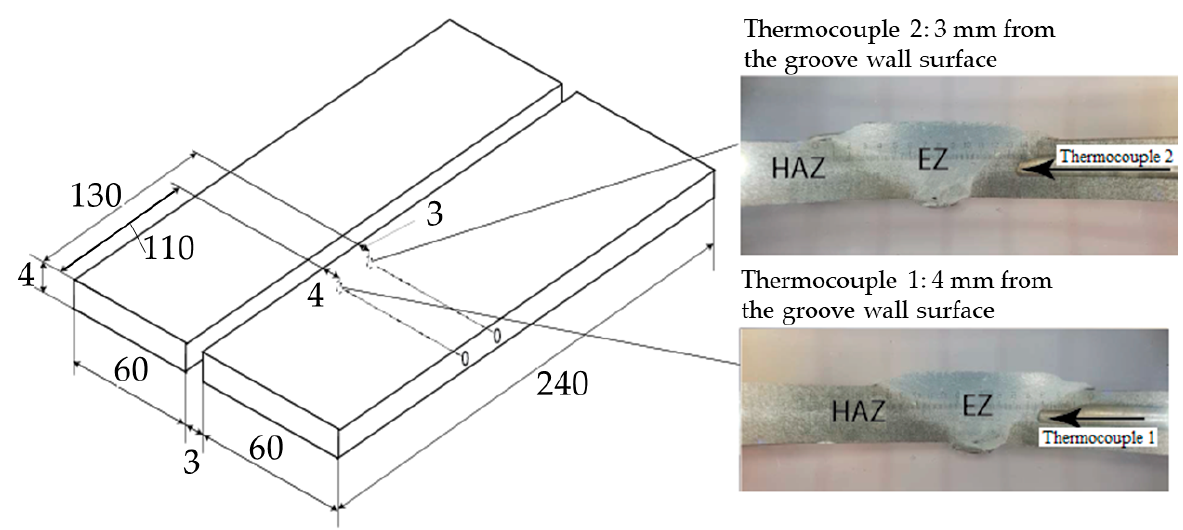
Figure 6. Workpiece dimensions and locations of thermocouples.